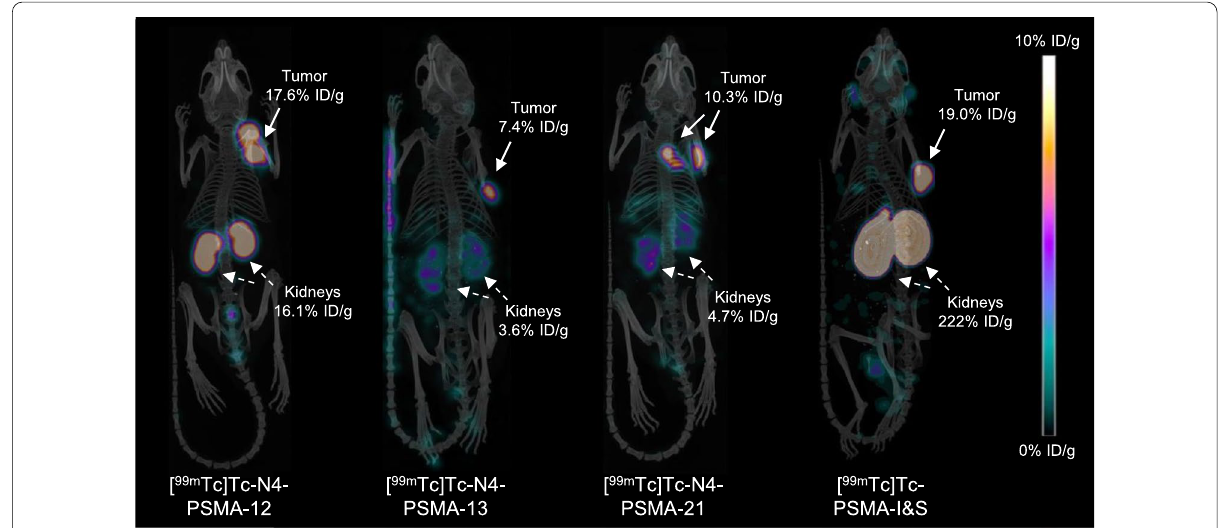
Fig. 4 Static µSPECT/CT images (maximum intensity projections) of 99m Tc‑labeled N4‑PSMA‑derivatives and [ 99m Tc]Tc‑PSMA‑I&S in LNCaP tumor‑bearing mice. Animals were sacrificed at 6 h p.i. and imaged directly after blood collection for 45 min on a VECTor4 small‑animal SPECT/PET/ OI/CT. Tracer uptake in tumor and kidneys (in percent of the injected dose/gram, (% ID/g)) was determined from subsequent biodistribution